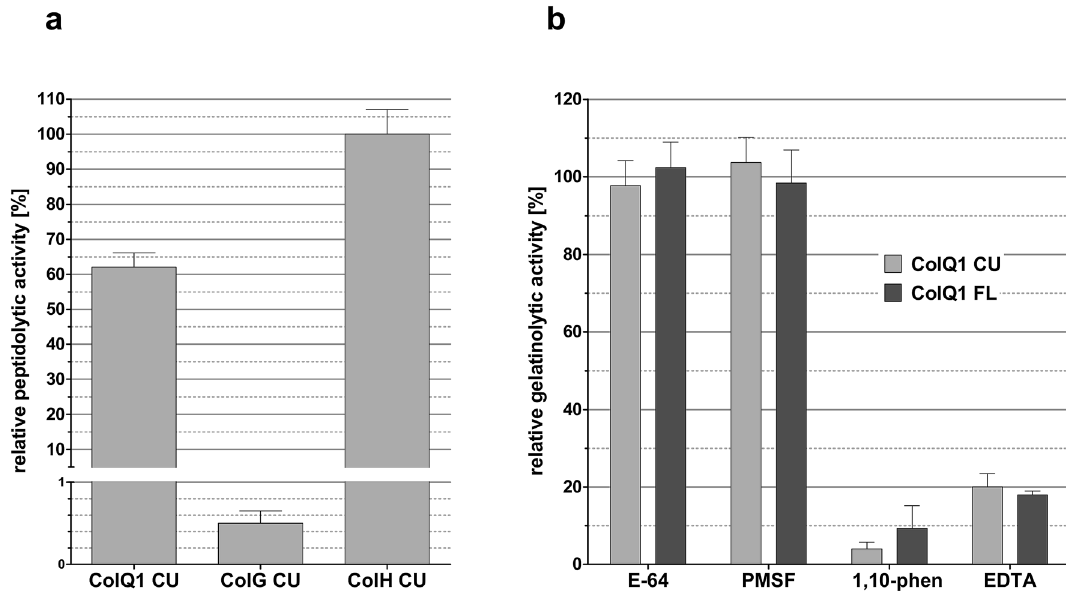
Figure 4. Initial enzymatic characterization of ColQ1. ( a ) Relative peptidolytic activities of ColQ1 CU, ColG CU and ColH CU against the collagenase-specific peptide substrate FALGPA. Data shows mean ± SD (ColH CU: n = 3, ColG CU/ColQ1 CU: n = 5). ( b ) Relative activities of ColQ1 FL and CU against fluorescein-labelled gelatin (DQ gelatin, Molecular Probes) after incubation with cysteine- and serine protease inhibitors E-64 and PMSF and metalloprotease inhibitors 1,10-phenanthroline and EDTA. Data are graphed as mean ± SD (n = 3).